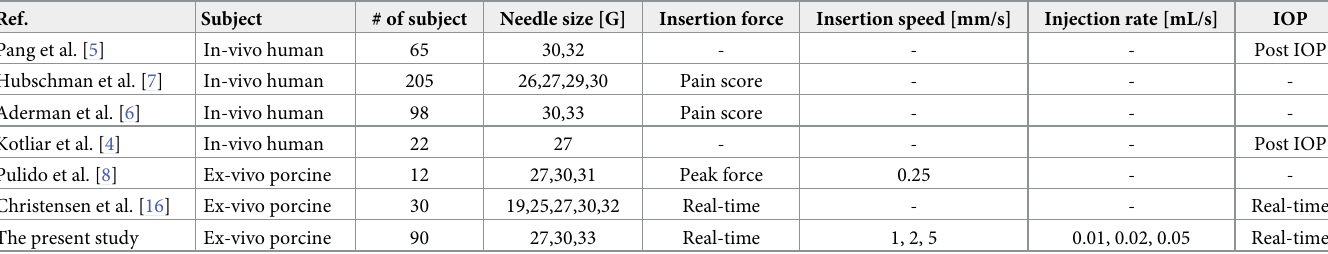
Table 1. Summary of previous studies on insertion force and intraocular pressure (IOP) changes during intravitreal injection.